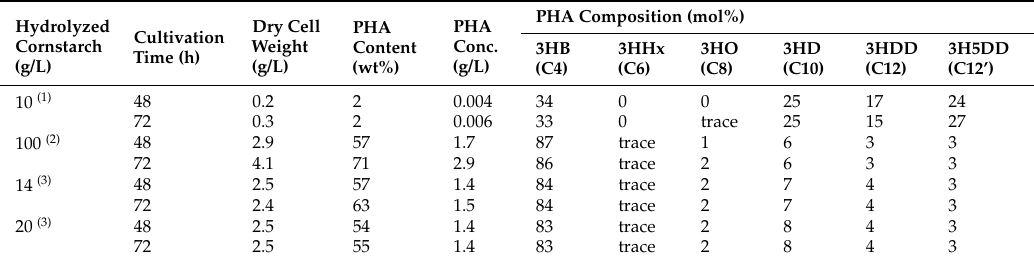
Table 5. Biosynthesis of PHA in Pseudomonas sp. 61-3 ( phbC :: tet ) harboring pJKSc54- phab from hydrolyzed